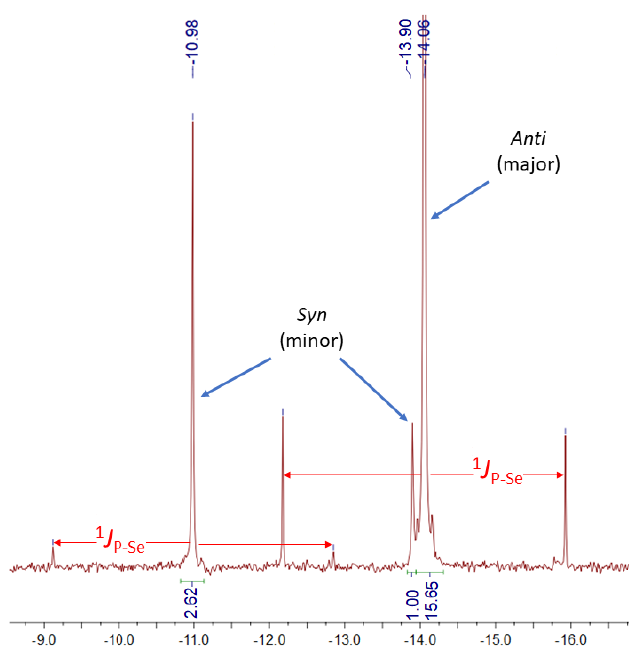
Figure 2. Isomeric forms of compounds 1 – 3 .